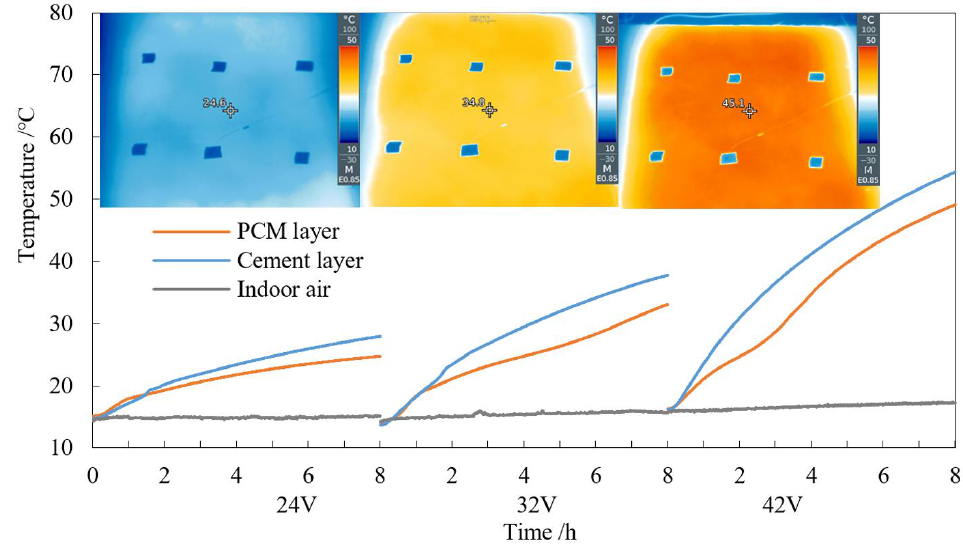
Figure 13. Temperature comparison test results of layer V between two wallboards (heat storage process).